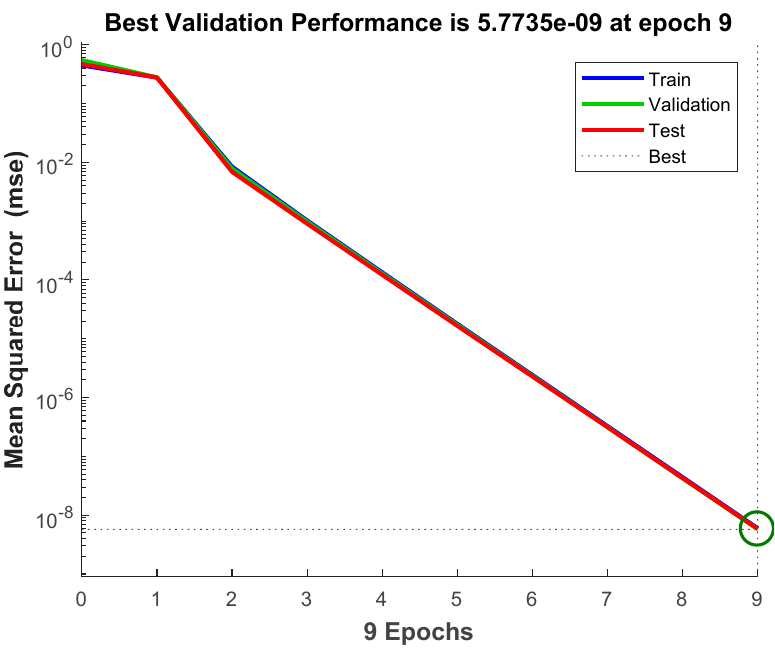
Figure 14. Training performance of the proposed DNN classifier.